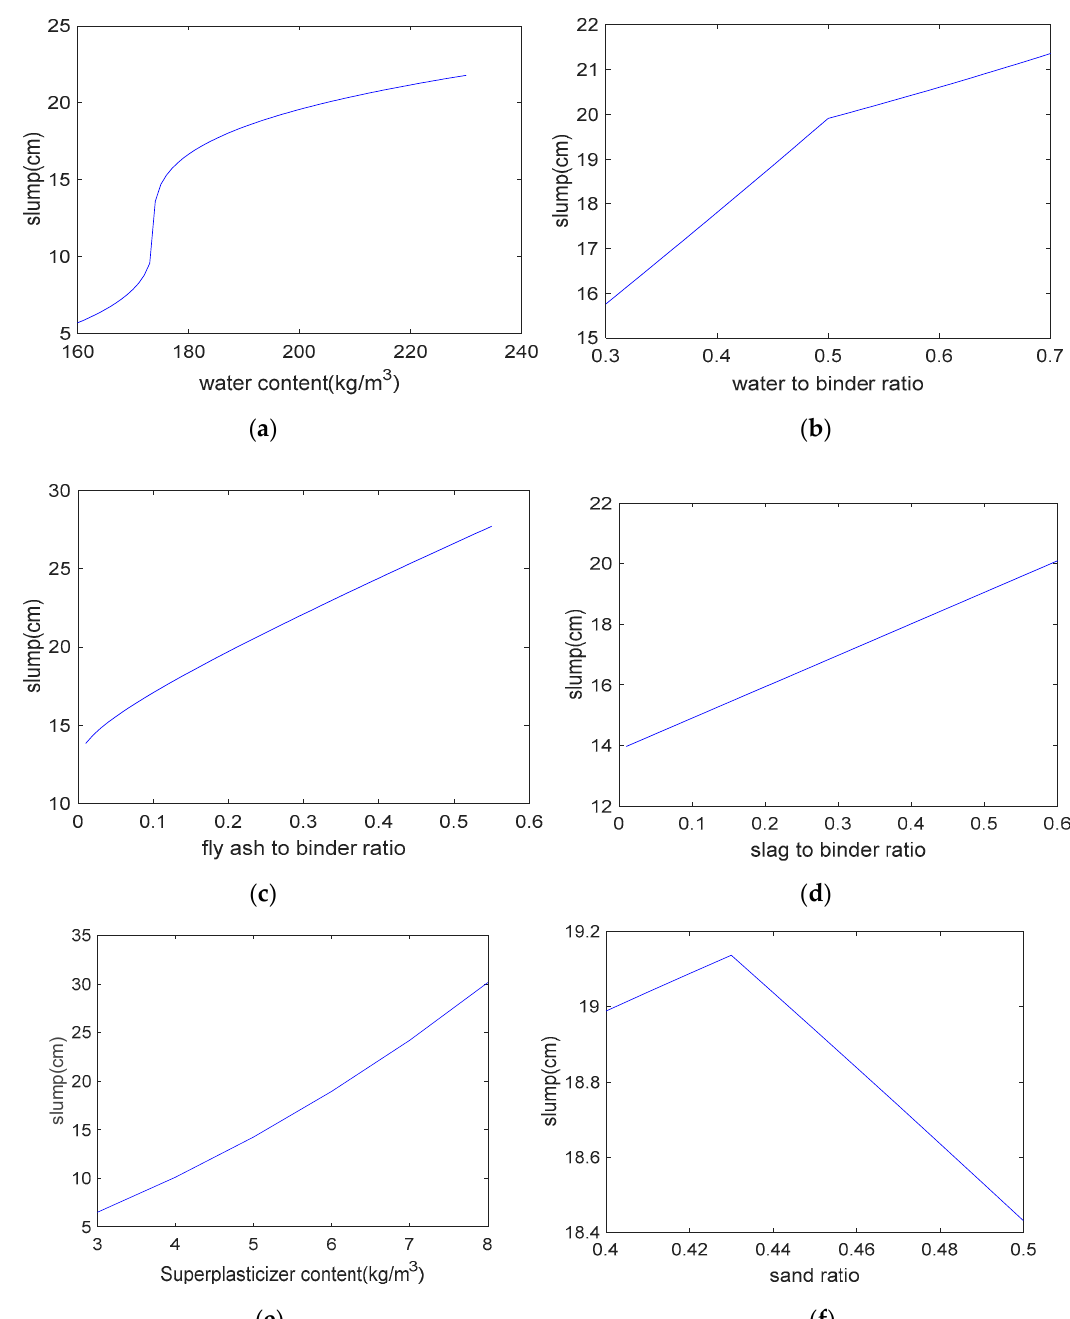
Figure 5. Experimental results vs. prediction results on slump.